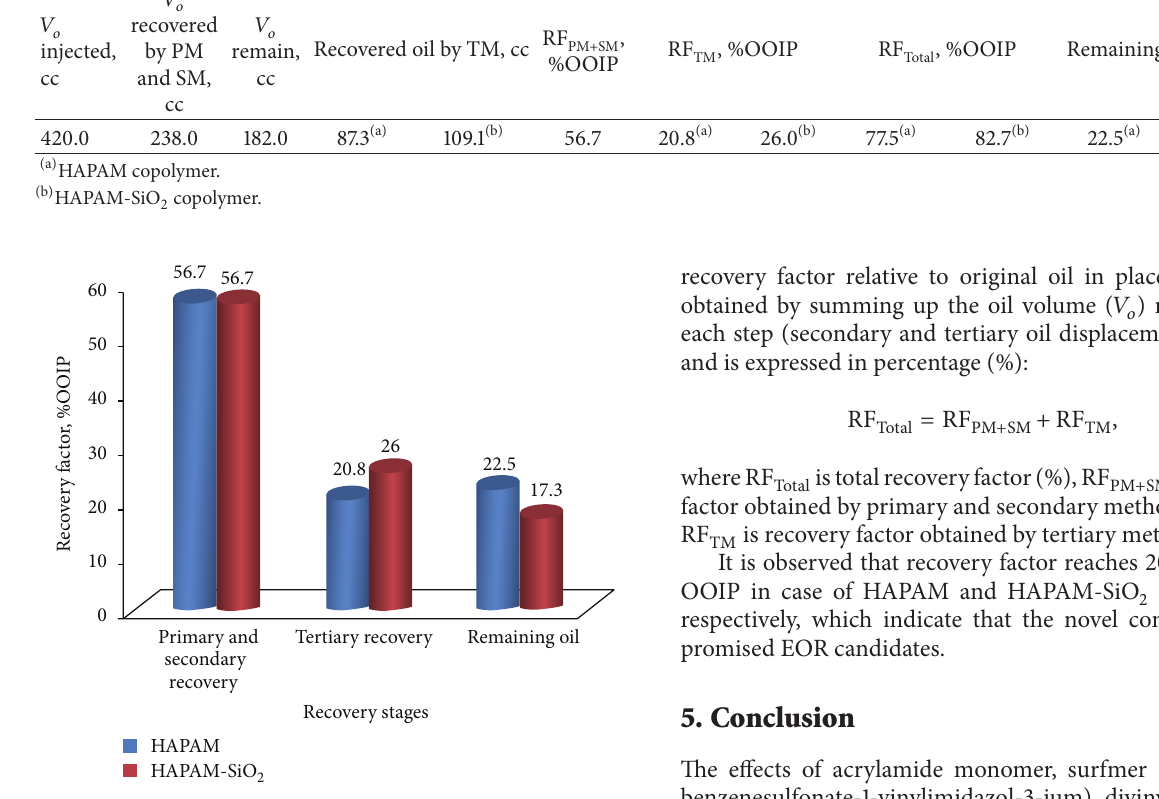
Figure 13: Recovery factor related to